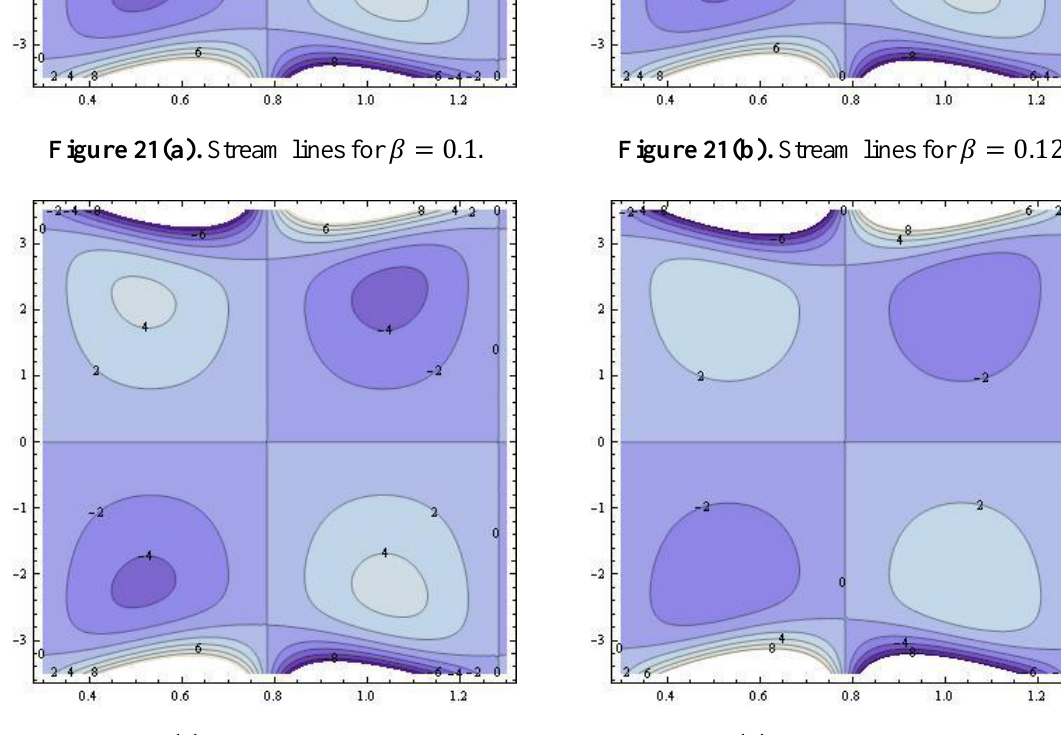
Figure 22(a). Stream lines for 𝑀 = 1. Figure 22(b): Stream lines for 𝑀 = 1.2